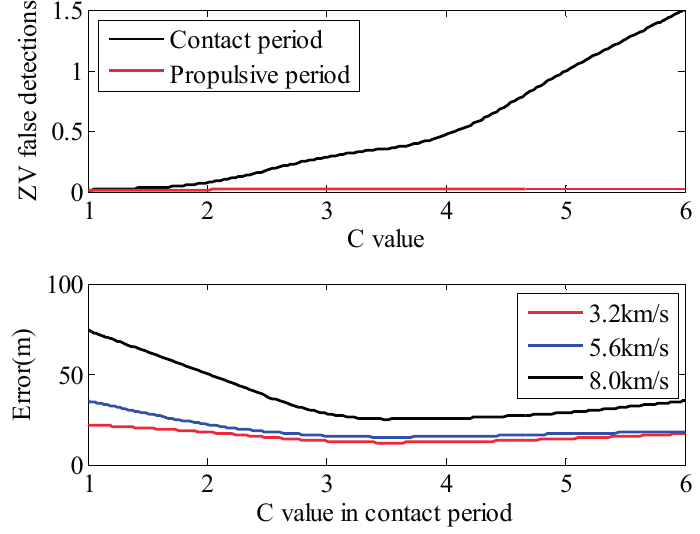
Figure 9. The average ZV detections in the contact period and propulsive period with different C values in Formula (11) and horizontal position errors with different C values in the contact